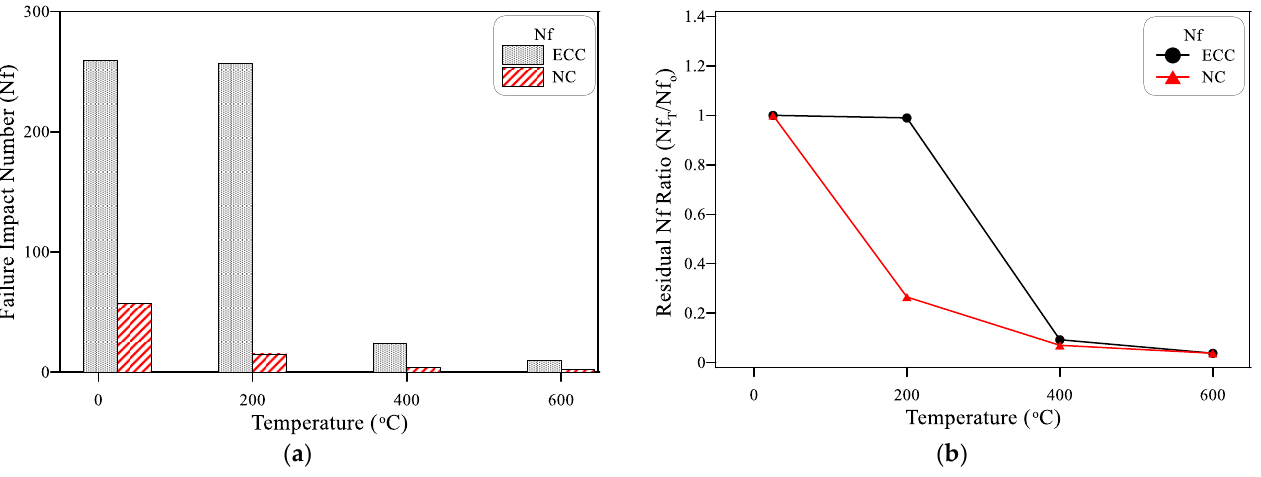
Figure 10. Residual failure impact numbers of ECC and NC at different temperatures; ( a ) failure number; ( b ) residual ratio of failure number.